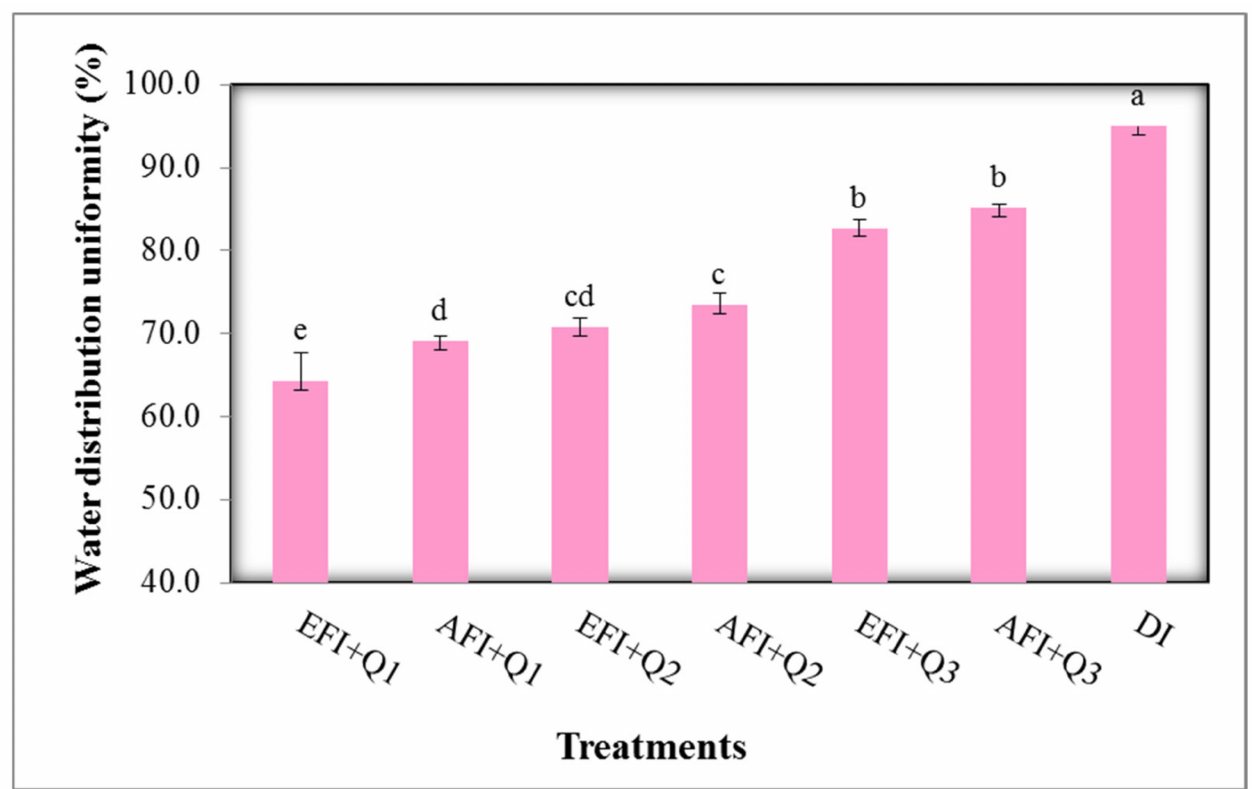
Figure 2. The effect of irrigation systems (EFI, AFI, and DI) and flow rates (0.47 (Q1), 0.95 (Q2), and 1.43 L/s (Q3)) on the water distribution uniformity across two seasons. Mean values followed by the same letter were not significantly different at the 5% level between